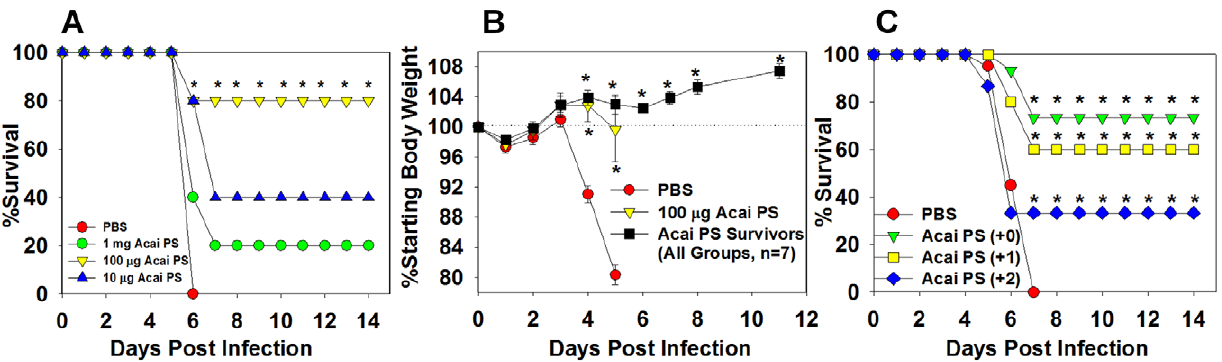
Figure 4. Nasal administration of Acai PS confers prophylactic and therapeutic protection against pulmonary Type A F.tularensis infection. Female C57BL/6 mice (5/group) were treated with PBS or with 10, 100, 1000 m g of Acai PS by the intranasal (i.n.) route one day prior to aerosol infection with F. tularensis SchuS4. A) Mice were monitored for morbidity and mortality twice daily for a period of 14–28 days, at which time survivors were euthanized, and B) body weights were monitored. C) Female C57BL/6 mice (n=15–20/group) were i.n. treated with PBS or with 100 m g of Acai PS immediately after, one day after, or two days after aerosol infection with F. tularensis SchuS4. Mice were monitored for morbidity and mortality. *P , 0.05 as compared to PBS group. Error bars depict S.D. Data depicted in C) are pooled from two independent experiments.